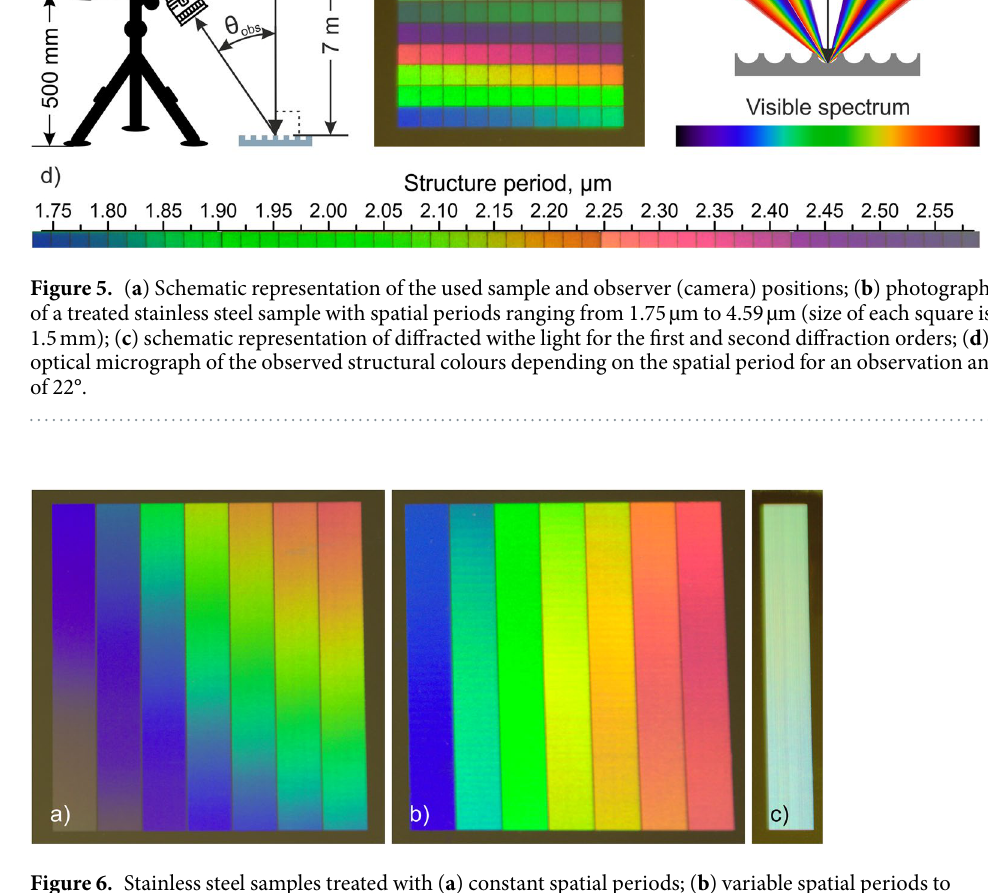
Figure 6. Stainless steel samples treated with ( a ) constant spatial periods; ( b ) variable spatial periods to increase the homogeneity of the structural colours and ( c ) with multiple variable spatial periods for mixing colours (following the strategy of Fig. 7).